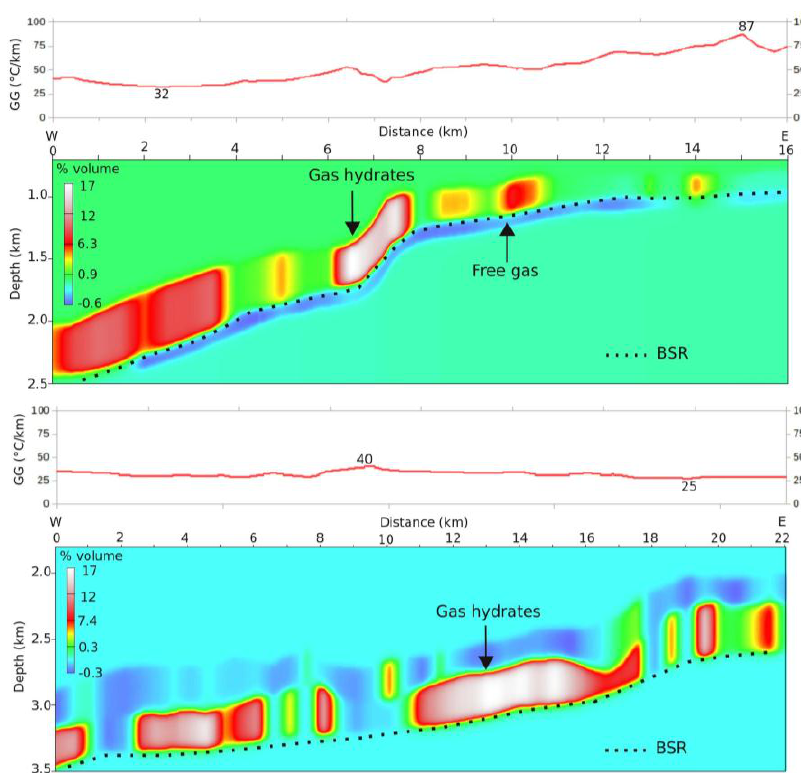
Figure 3. Gas hydrate (positive values) and free gas (negative values) concentration models. The BSR is indicated by dotted lines. GG (red lines) indicates the geothermal gradient estimated by BSR depth. See text for details. The numbers reported across the red line indicate the upper and lower GG values.